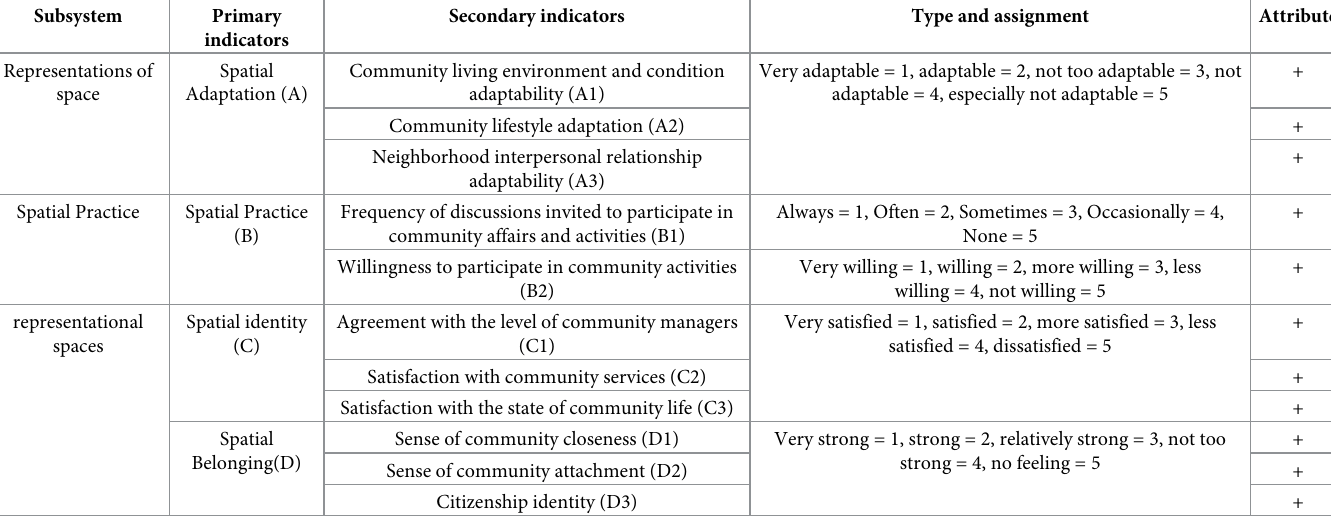
Table 1. Evaluation index system of the social space integration level of ecological